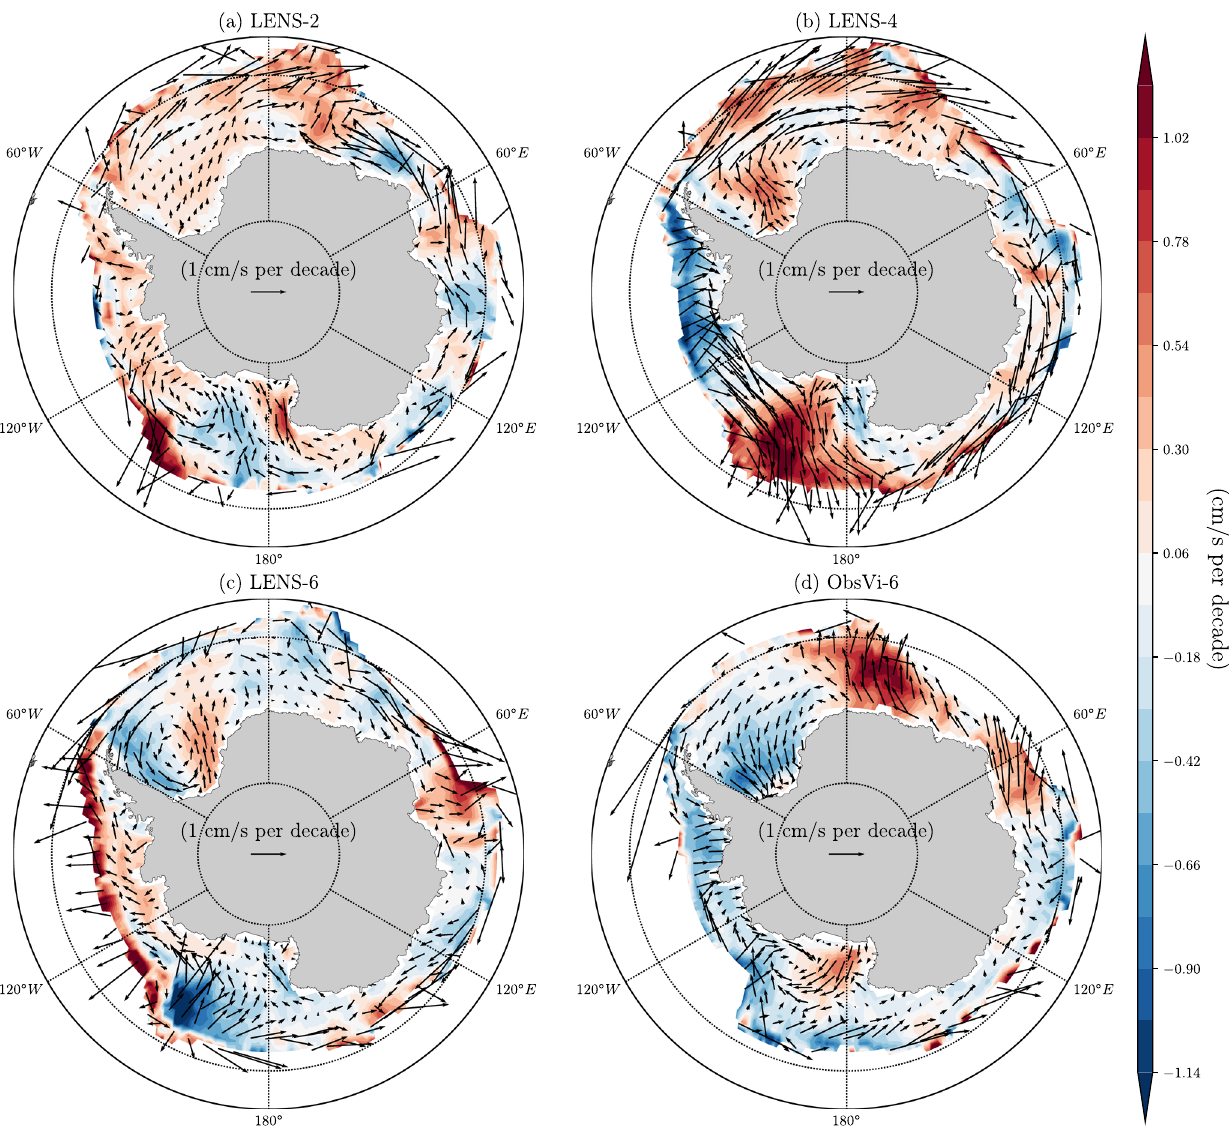
Fig. 1 Antarctic sea ice drift velocity trend. Linear trend in the annual-mean sea ice drift velocity (vector) during 1992 – 2015, with the linear trend in the meridional velocity component also indicated (shading), in a LENS-2, b LENS-4, c LENS-6, and d ObsVi-6. Note that the sea ice velocity trends in the observations, ObsVi-2, and ObsVi-4 are approximately equivalent to ObsVi-6 (see Supplementary